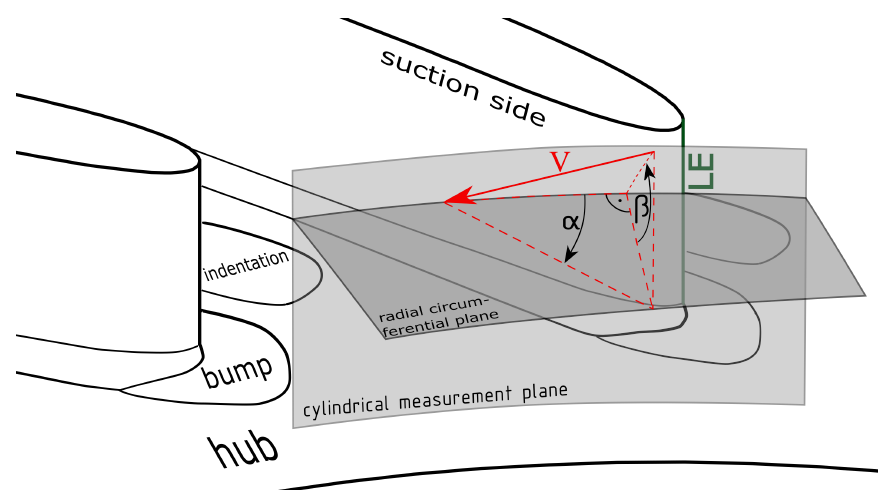
Figure 4. Measurement plane of 5-hole probe and illustration of flow angles.